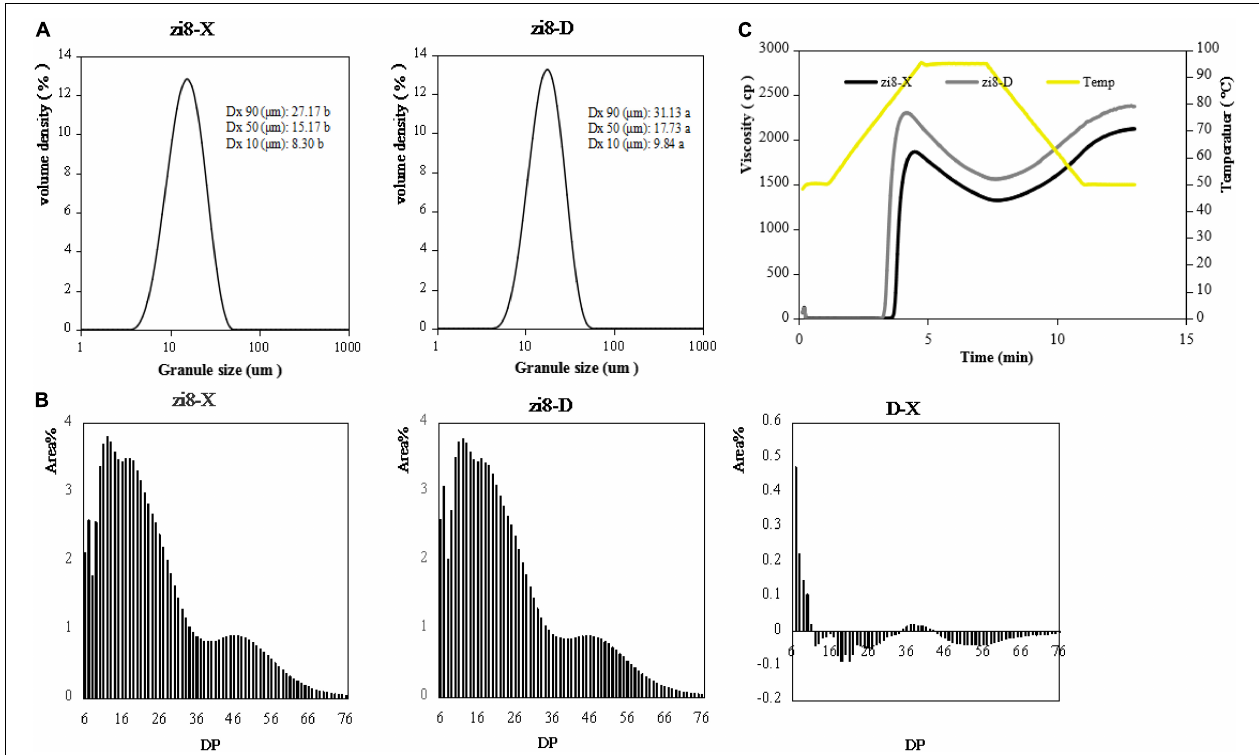
FIGURE 3 | Physicochemical properties of starch from zi8-X and zi8-D. (A) Particle size distribution; (B) Curves of chain length distributions of zi8-X and zi8-D; (C) RVA pasting profiles of zi8-X and